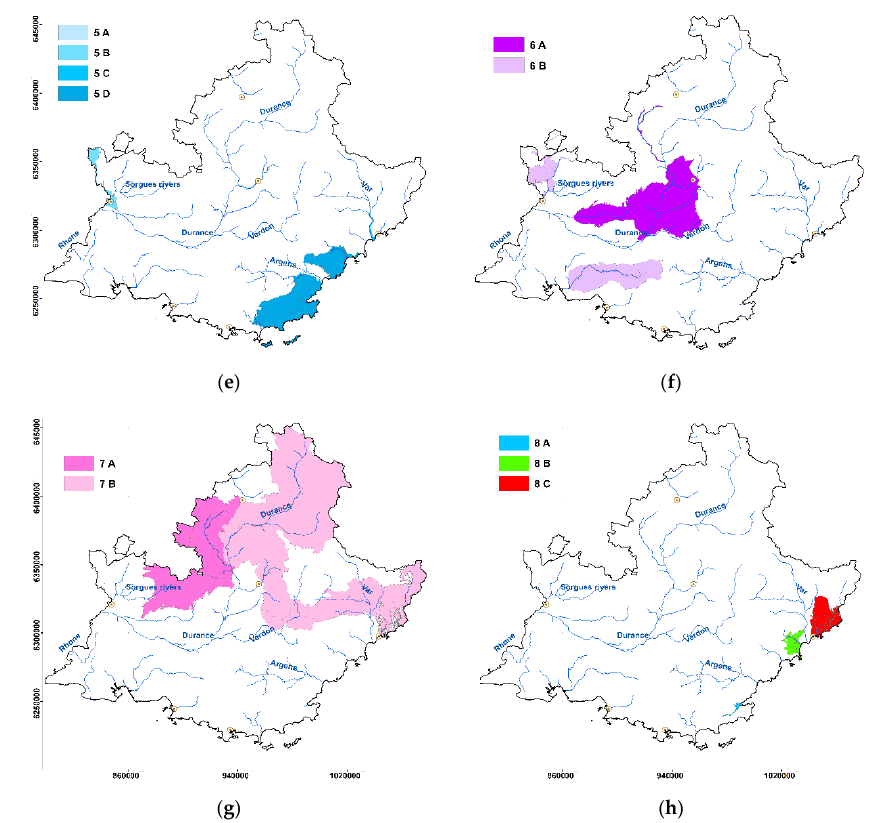
Figure 6. Distribution of eight main MESO groups in Provence-Alpes-Côte d’Azur (PACA) region, ( a – h ) for group 1 to 8, respectively.